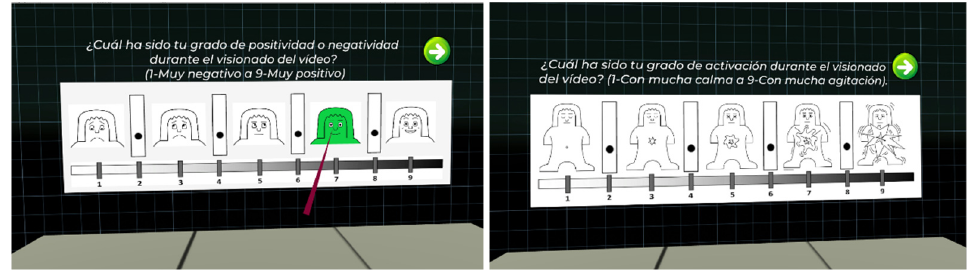
Figure 7. Labelling screen used in the experiment.